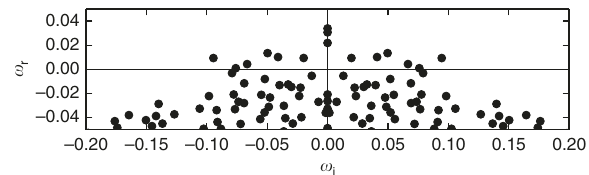
Fig. 3 Instability of the Nagata equilibrium creates oblique amplitude modulations. a Torus representing a streamwise – spanwise periodic domain. If tilted rectangular coordinate lines x and z (black) close on themselves, all solutions on the torus also respect the periodicity of a domain spanned by those lines. Speci fi cally, the Nagata equilibrium with streamwise – spanwise periodicity ( λ st , λ sp ) = (12.65, 4.22) (gray lines) is also periodic with respect to the tilted domain (black) with ( θ , L x , L z ) = (18.4°, 40/3, 40), shown in b for Re I = 164. In this tilted domain, a bifurcation with neutral eigenmode ( c ) can be detected at Re I . This bifurcation introduces oblique long-wavelength amplitude modulations on the Nagata equilibrium. Red (blue) contours represent positive (negative) streamwise velocity in the midplane